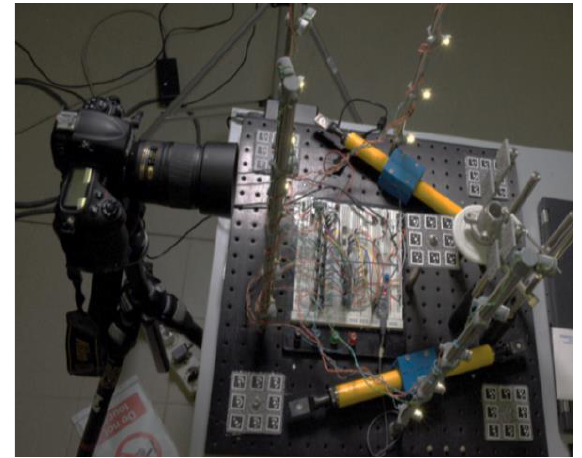
Figure 4. The prototype image acquisition system for combining photometric stereo and photogrammetry